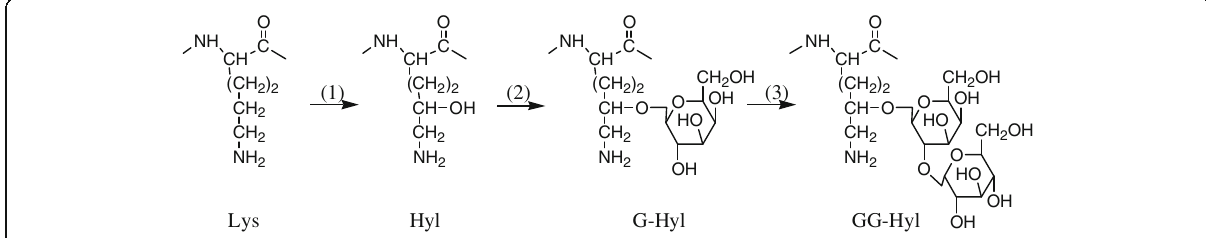
Fig. 5 Collagen decorated by oligosaccharide. Reaction 1 represents the hydroxylation of lysine in the collagen molecule; reaction 2 is the galactosylation of hydroxylysine; reaction 3 is the glucosylation of the galactosyl group. Reprinted from ref. [72], Copywright (2004), with permission from Portland Press,